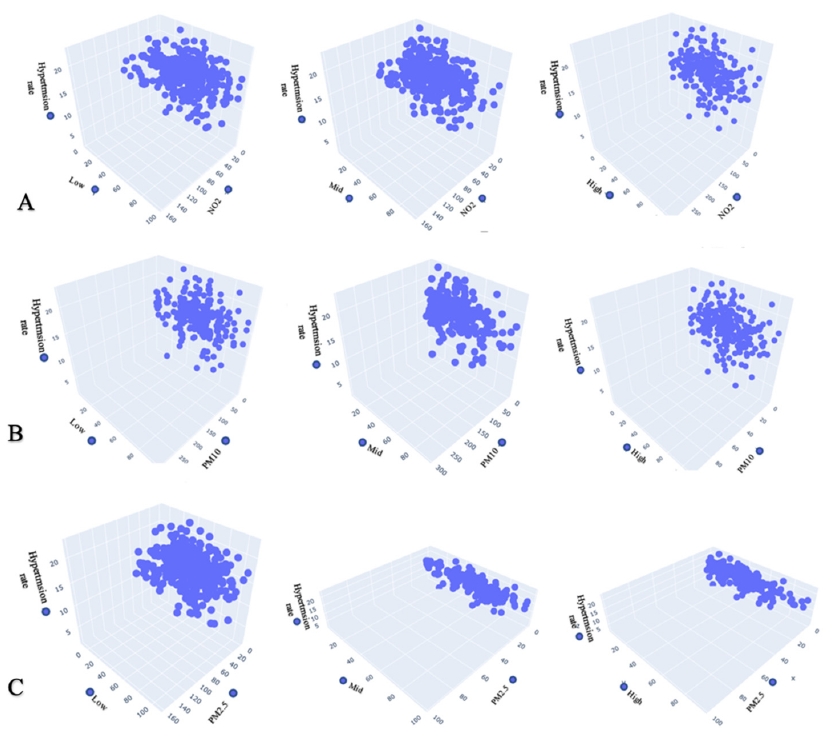
Figure 4. A 3D scatterplot showing the correlation between air concentration and noise level at different frequency components and hypertension